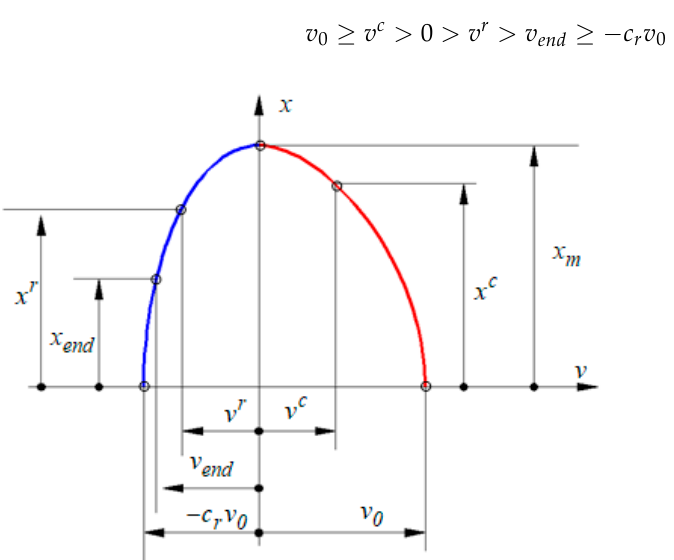
Figure 9. The subintervals from the phase portrait ensuring the convergence of the integrals from the expression of time.